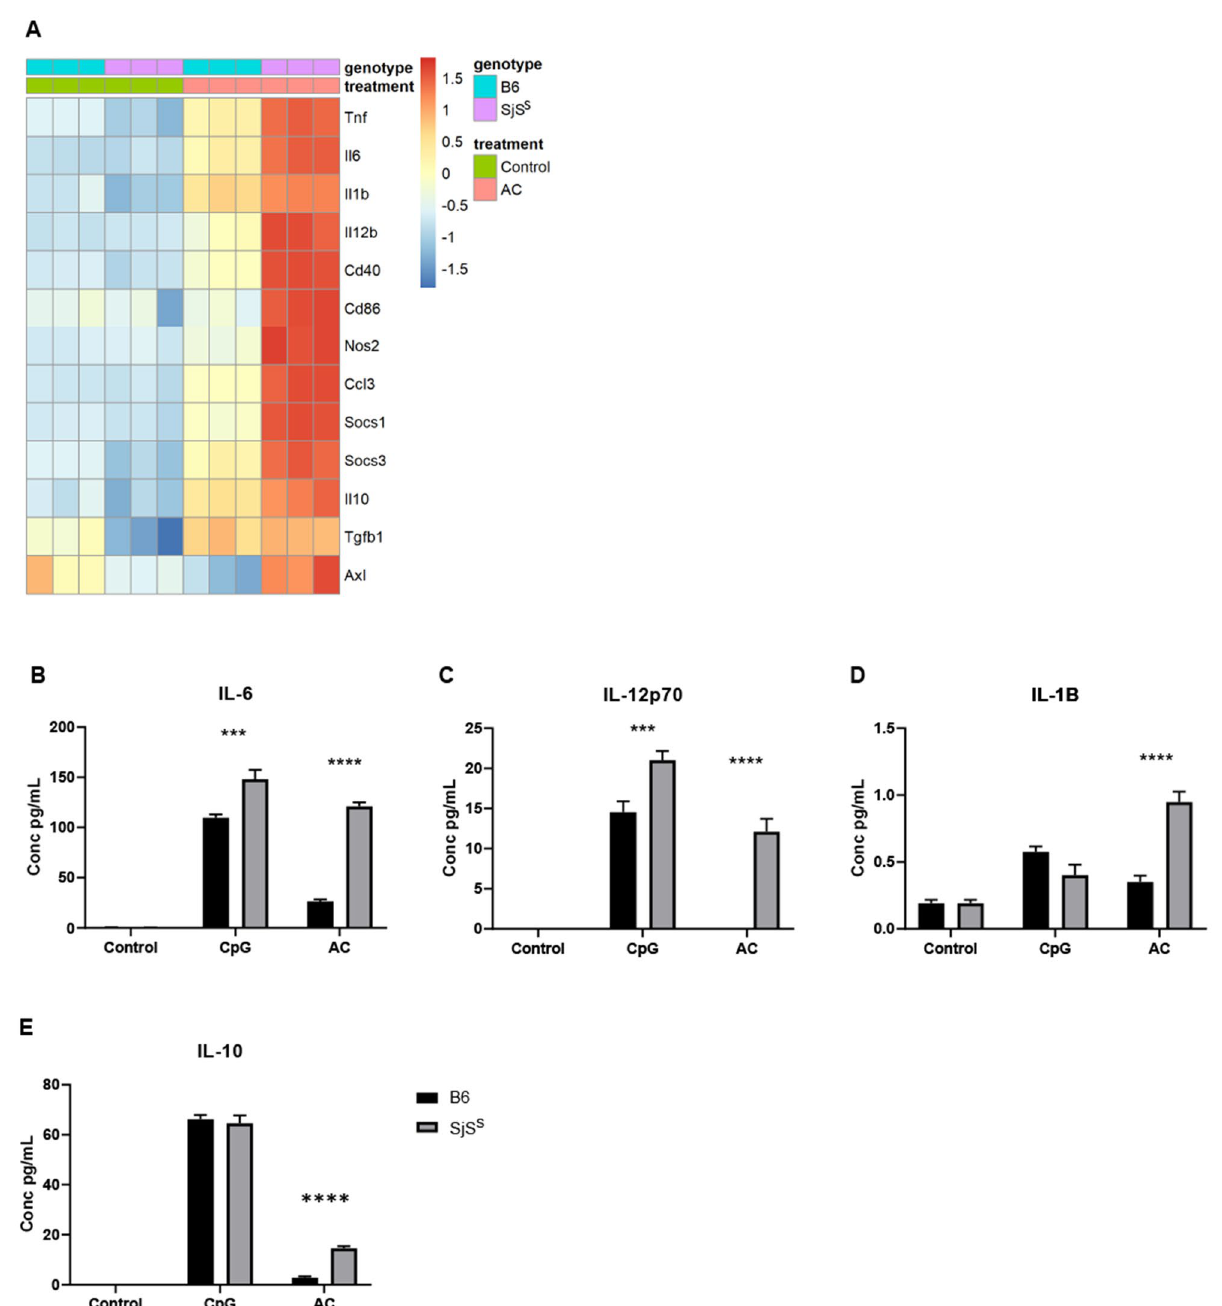
Figure 3. SjS S BMDMs produce inflammatory cytokines in response to apoptotic cells. ( A ) Heatmap depicting RNAseq analysis results for differentially expressed selected inflammatory genes in B6 and SjS S strains treated with Control, CpG, and AC conditions (n = 3 mice). ( B,E ) B6 (n = 3 mice) and SjS S (n = 3 mice) BMDMs were treated with CpG 1 µM or AC for 24 h, at which point media was collected for Bio-plex cytokine analysis. The statistical significance was calculated by two-tailed unpaired t -tests where error bars indicate SEM *** p < 0.001, and **** p <